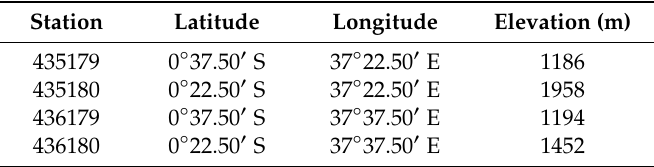
Table 8. General Circulation Model (GCM) stations